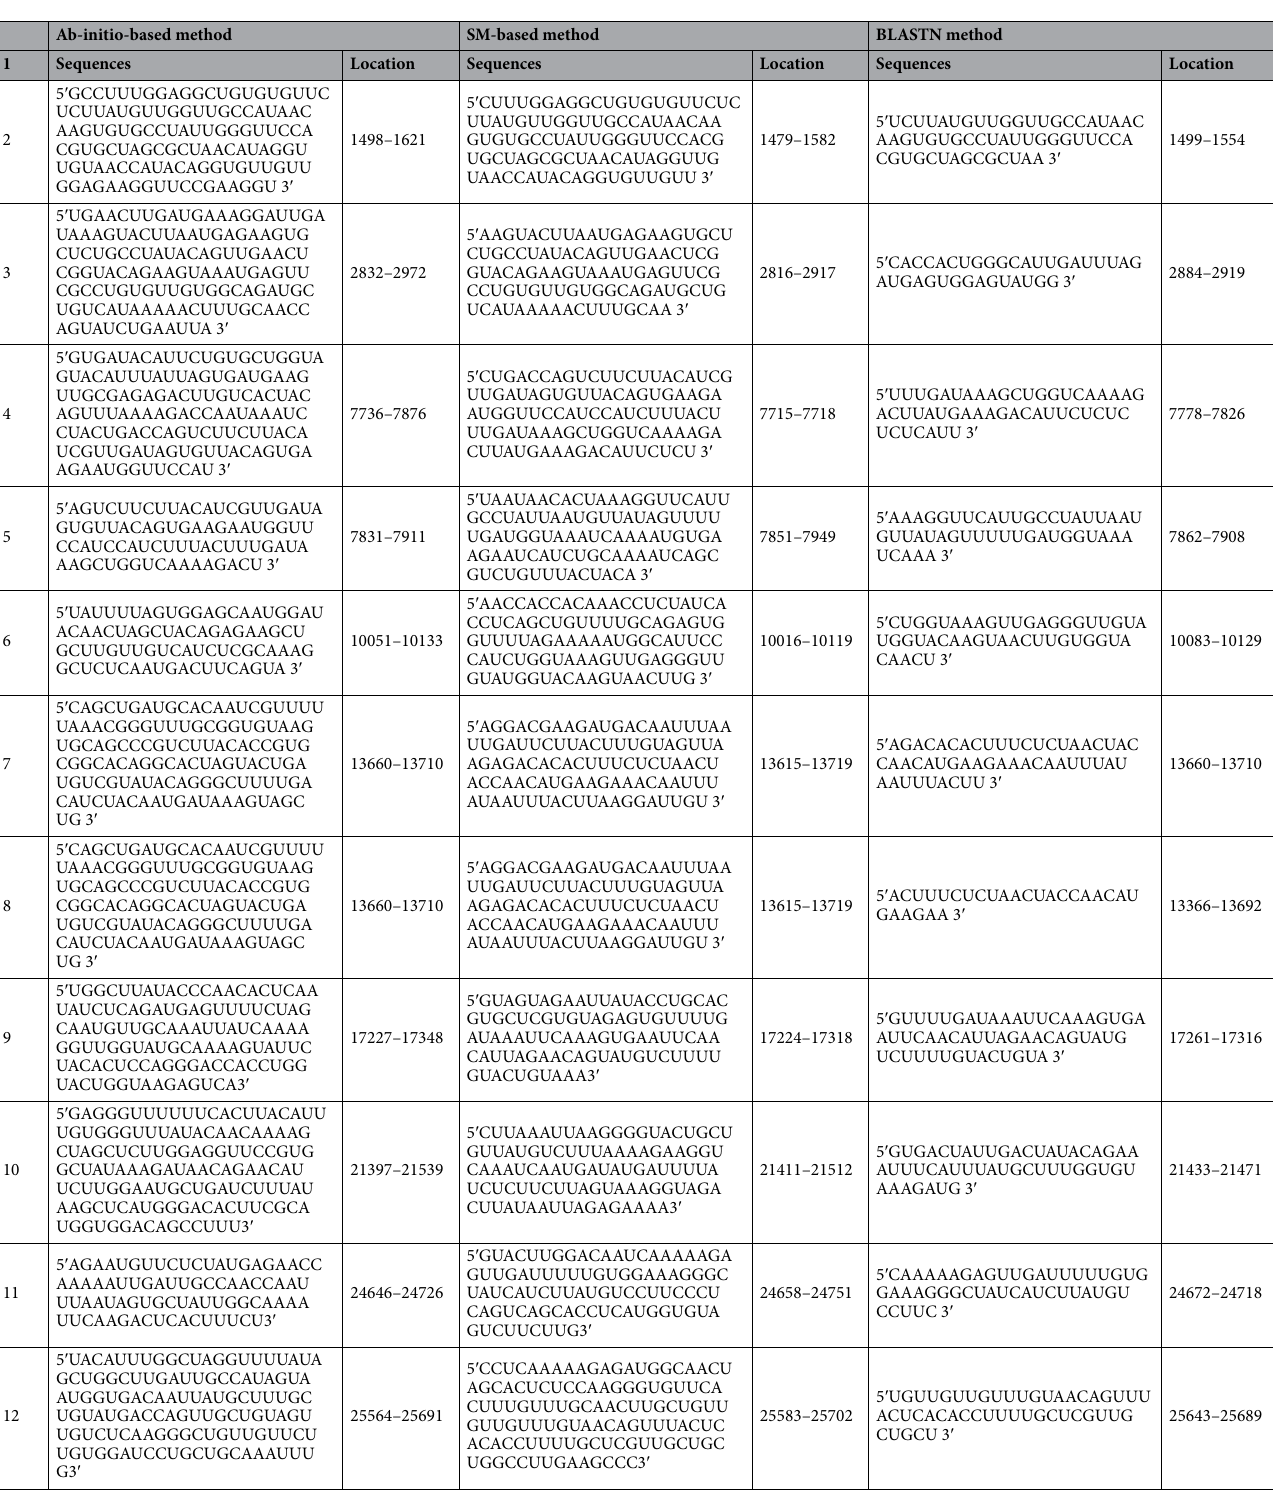
Table 1. Stem-loop structures co-predicted by three different methods in nearly the same genomic regions of the